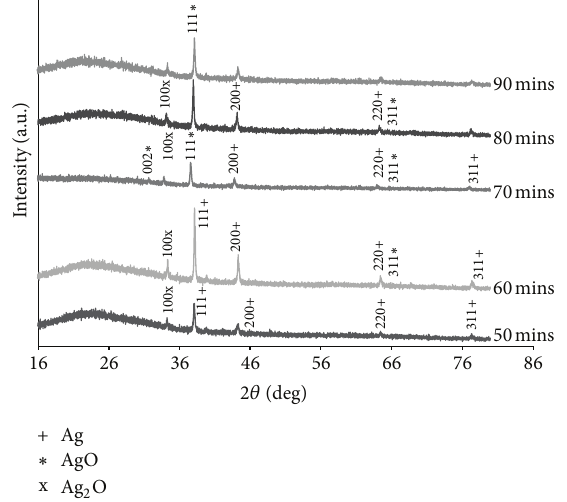
Figure 2: The XRD pattern of the deposited Ag 𝑥 O films at different deposition